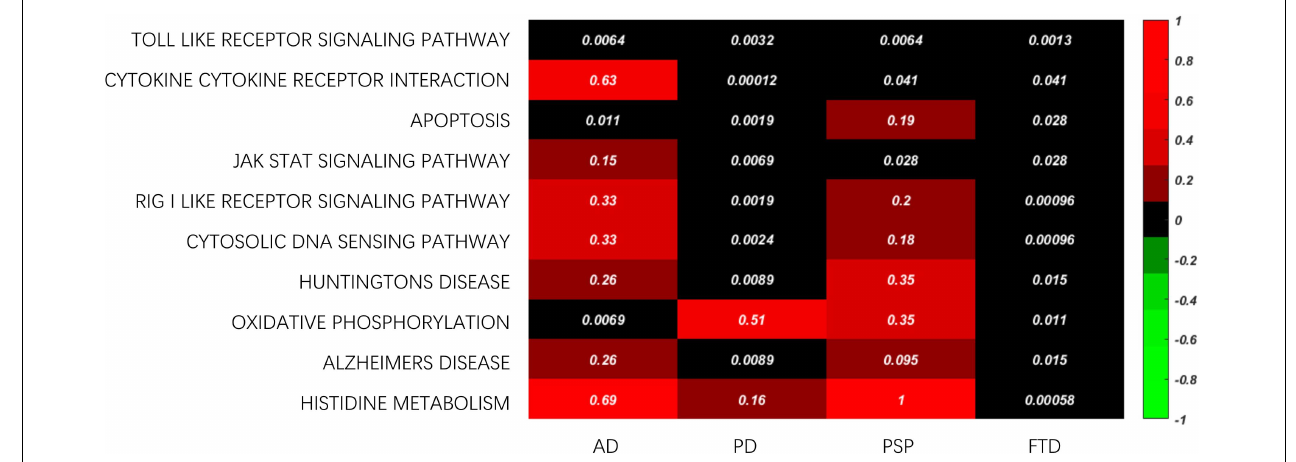
FIGURE 6 | The common enriched KEGG pathway across ND